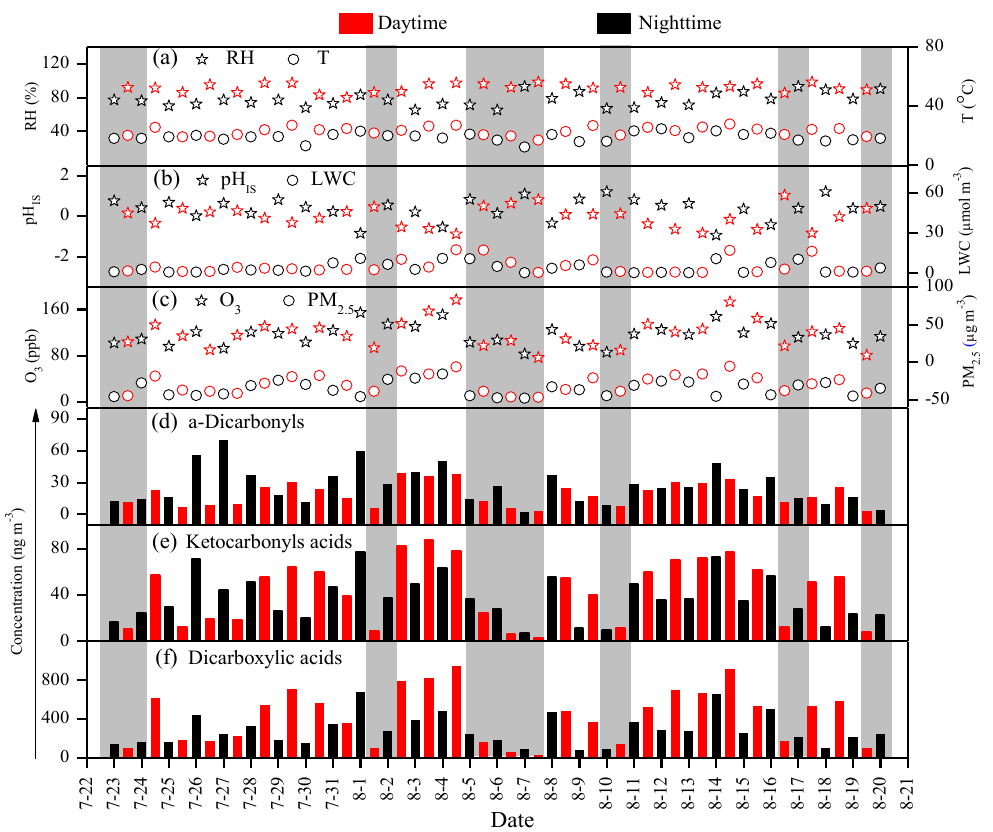
Figure 3. Diurnal variations of relative humidity (RH), temperature ( T ), in situ acidity of particles (pH IS ), liquid water content of particles (LWC), concentrations of O 3 , PM 2 . 5 , α -dicarbonyls, ketocarboxylic acids and dicarboxylic acids (rainy days are highlighted by the grey